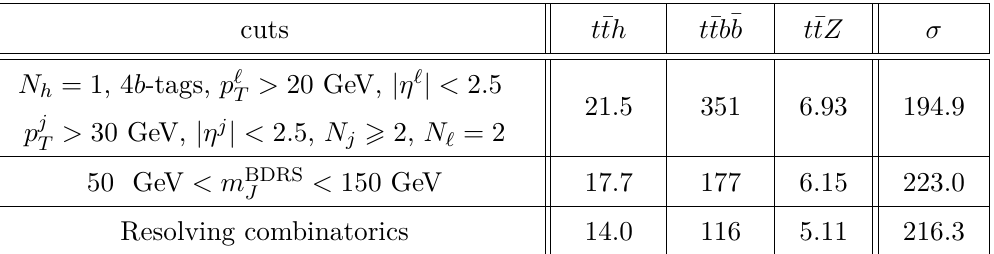
Table 2 . Cumulative cut-flow table showing cross-section in fb for t ¯ th signal ( κ t = 1 , α = 0 ) and leading backgrounds t ¯ tb ¯ b and t ¯ tZ at a 100 TeV future collider. The signal significances ( σ ) are calculated for a luminosity of 30 ab − 1